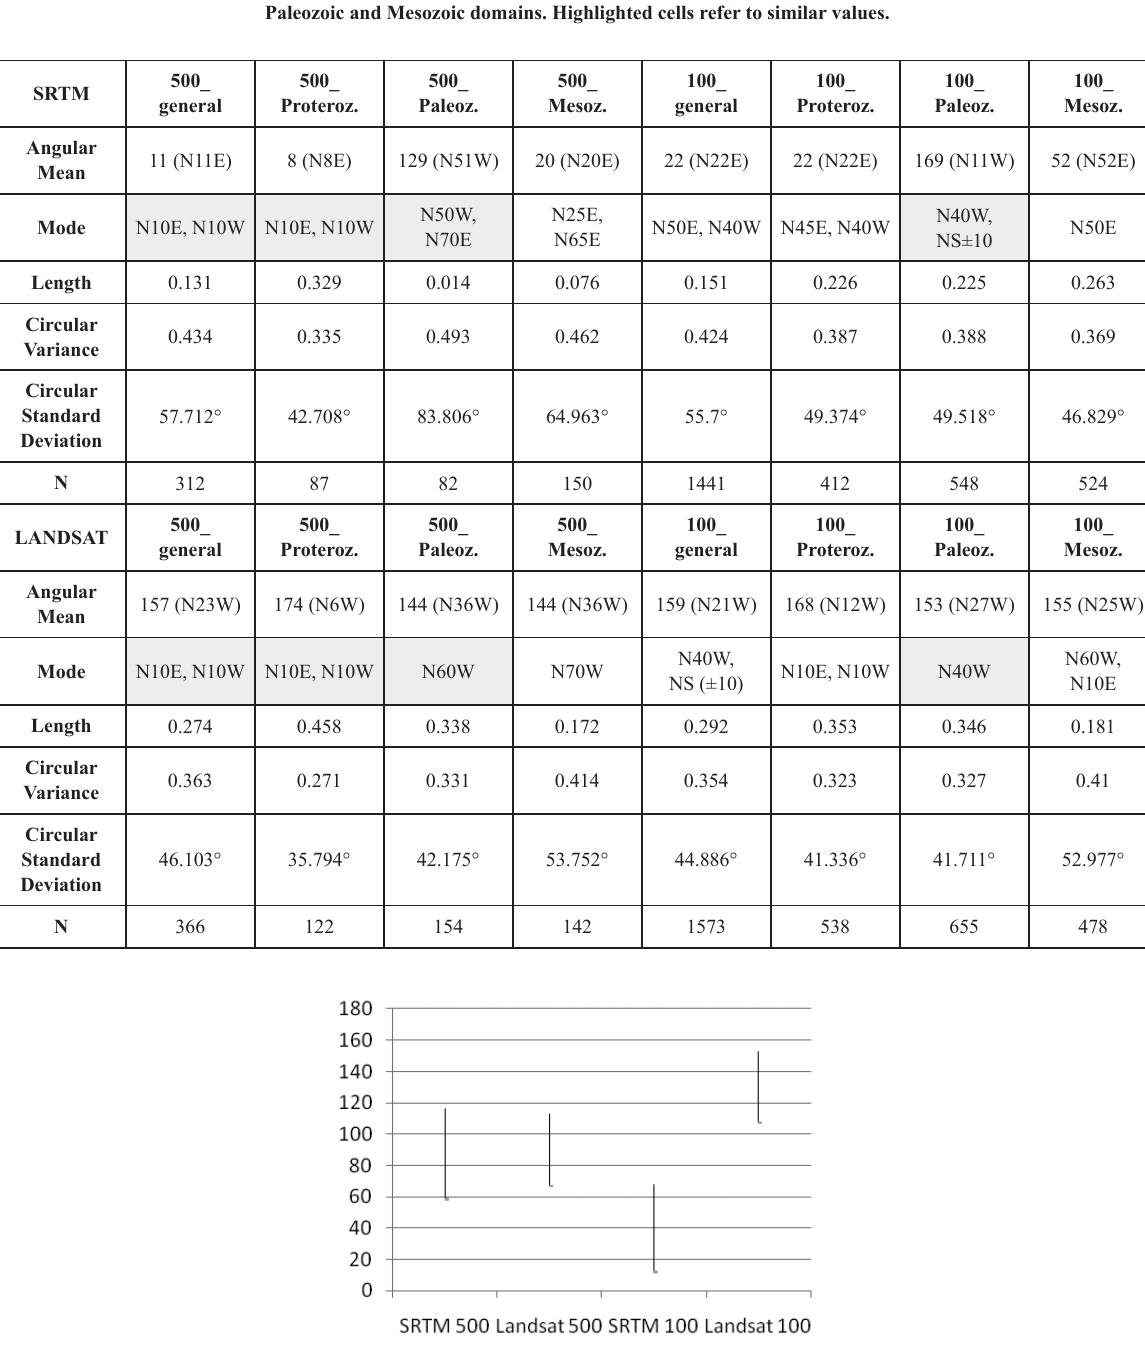
Figure 3 - General representation of lineaments extracted from SRTM and LANDSAT at both scales, based on the mode and circular standard deviation. The value 90 represents NS direction, value from 91 to 180 represents NW/ SE directions and value 0 to 89 represents NE/SW